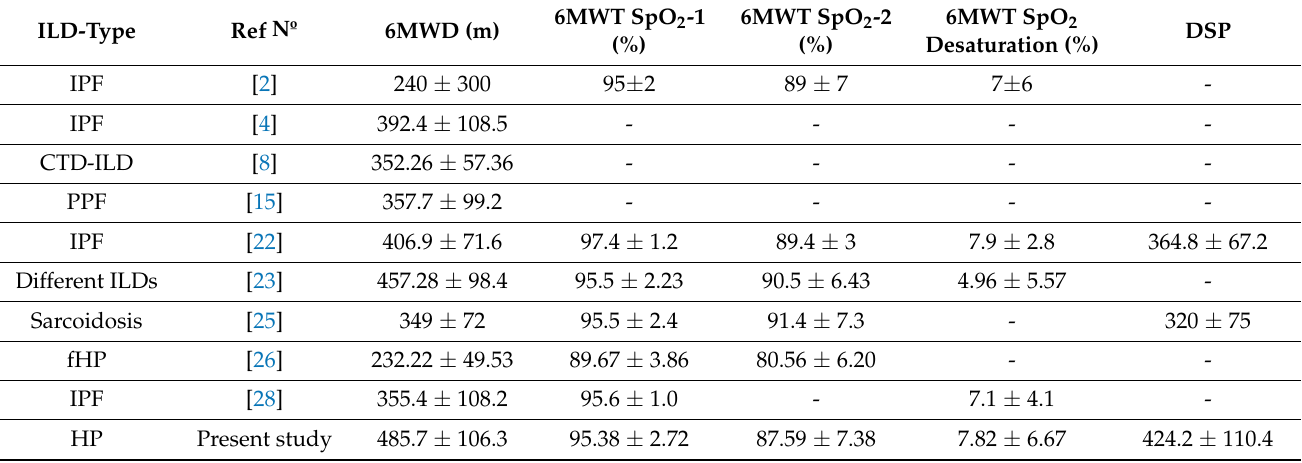
Table 7. Baseline 6MWT results (means ± SD) in different ILDs (reference-based).